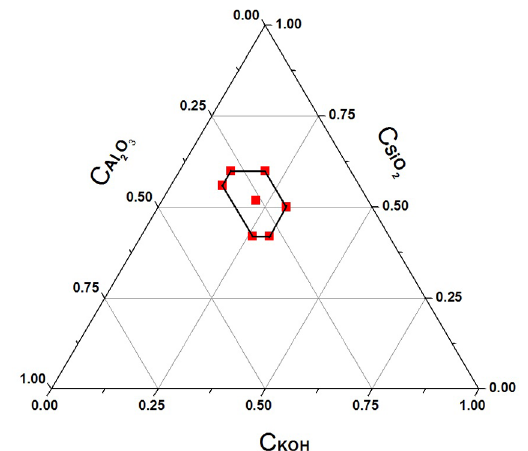
Figure 1. Three-component mixture design in terms of the real values.